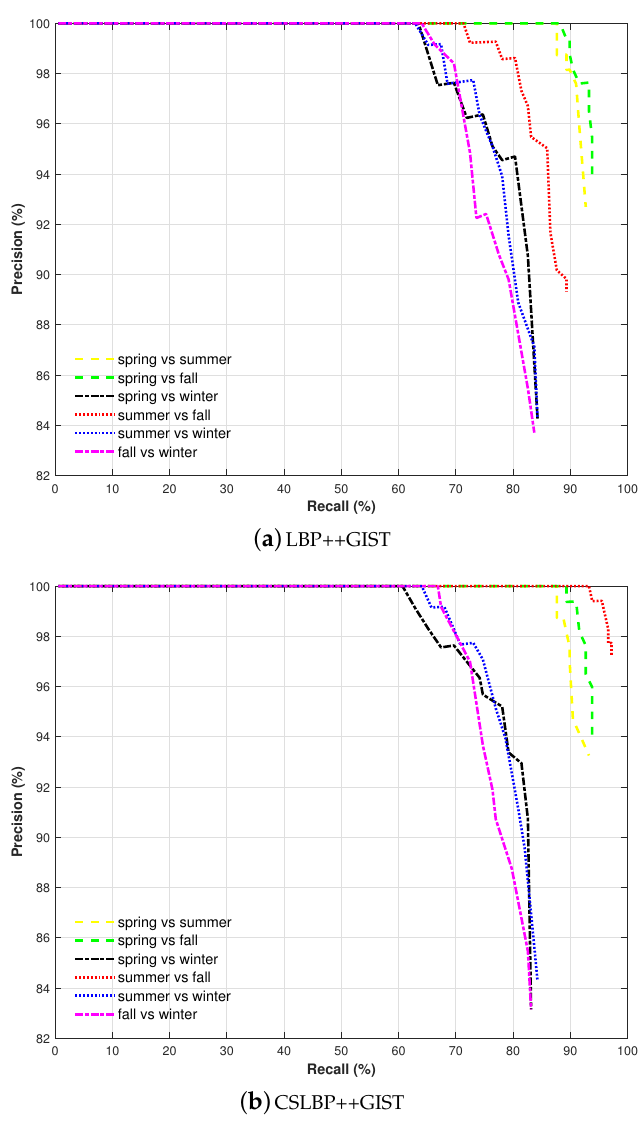
Figure 9. Precision–recall curves comparing the performance of different feature combination under different season